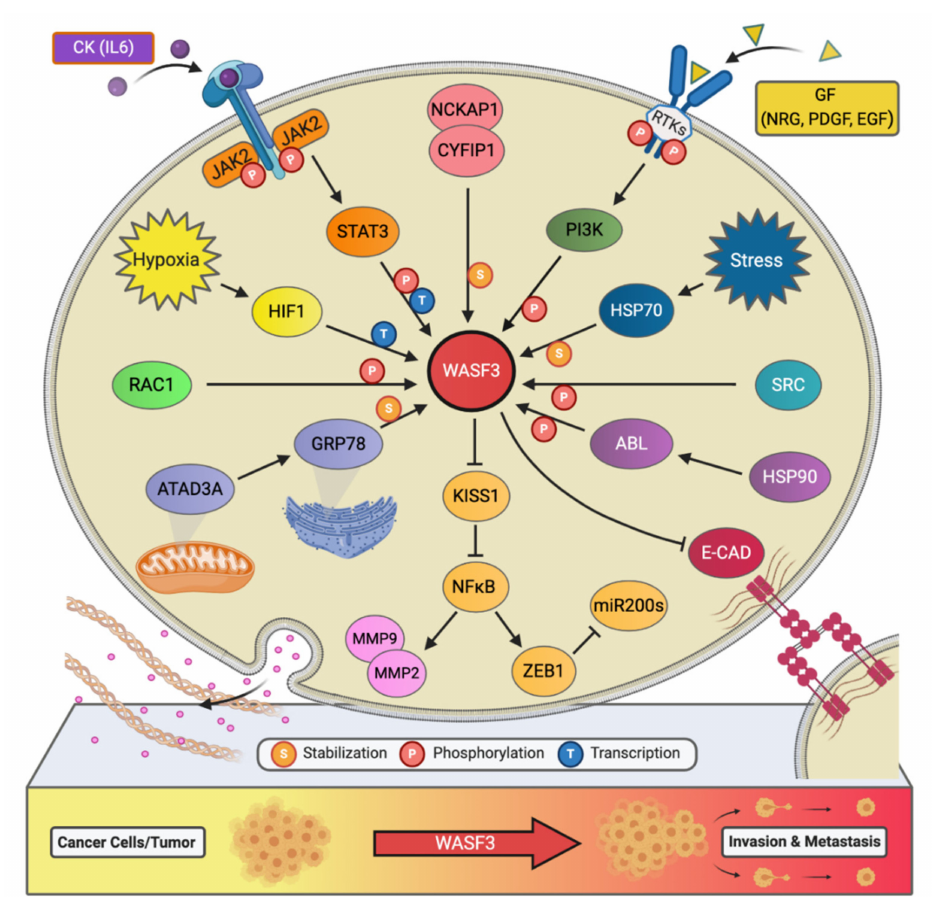
Figure 2. The signaling network of WASF3 in cancer metastasis. The WASF3-dependent signaling pathways and related regulatory networks critical to controlling cancer metastasis are summarized